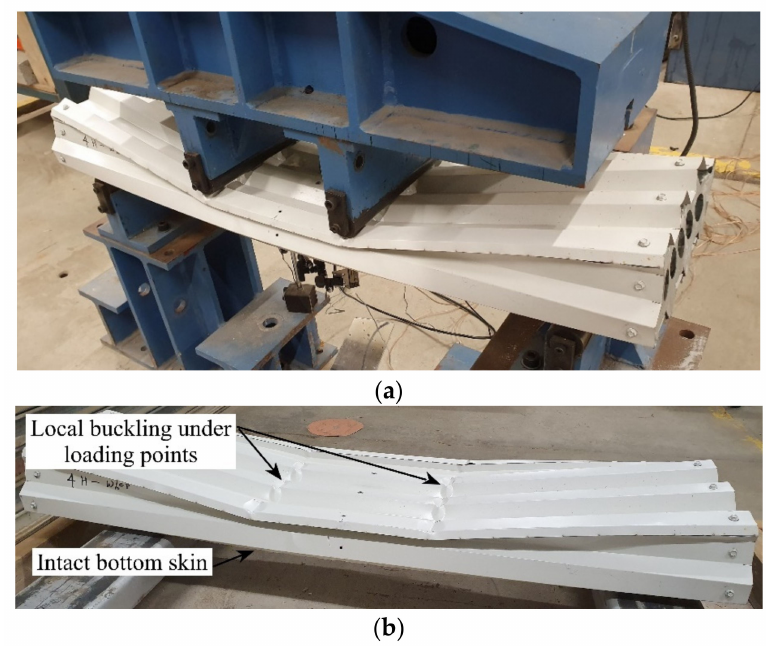
Figure 8. ( a ) Failure of SC panel. ( b ) Failed SC panel with the intact bottom